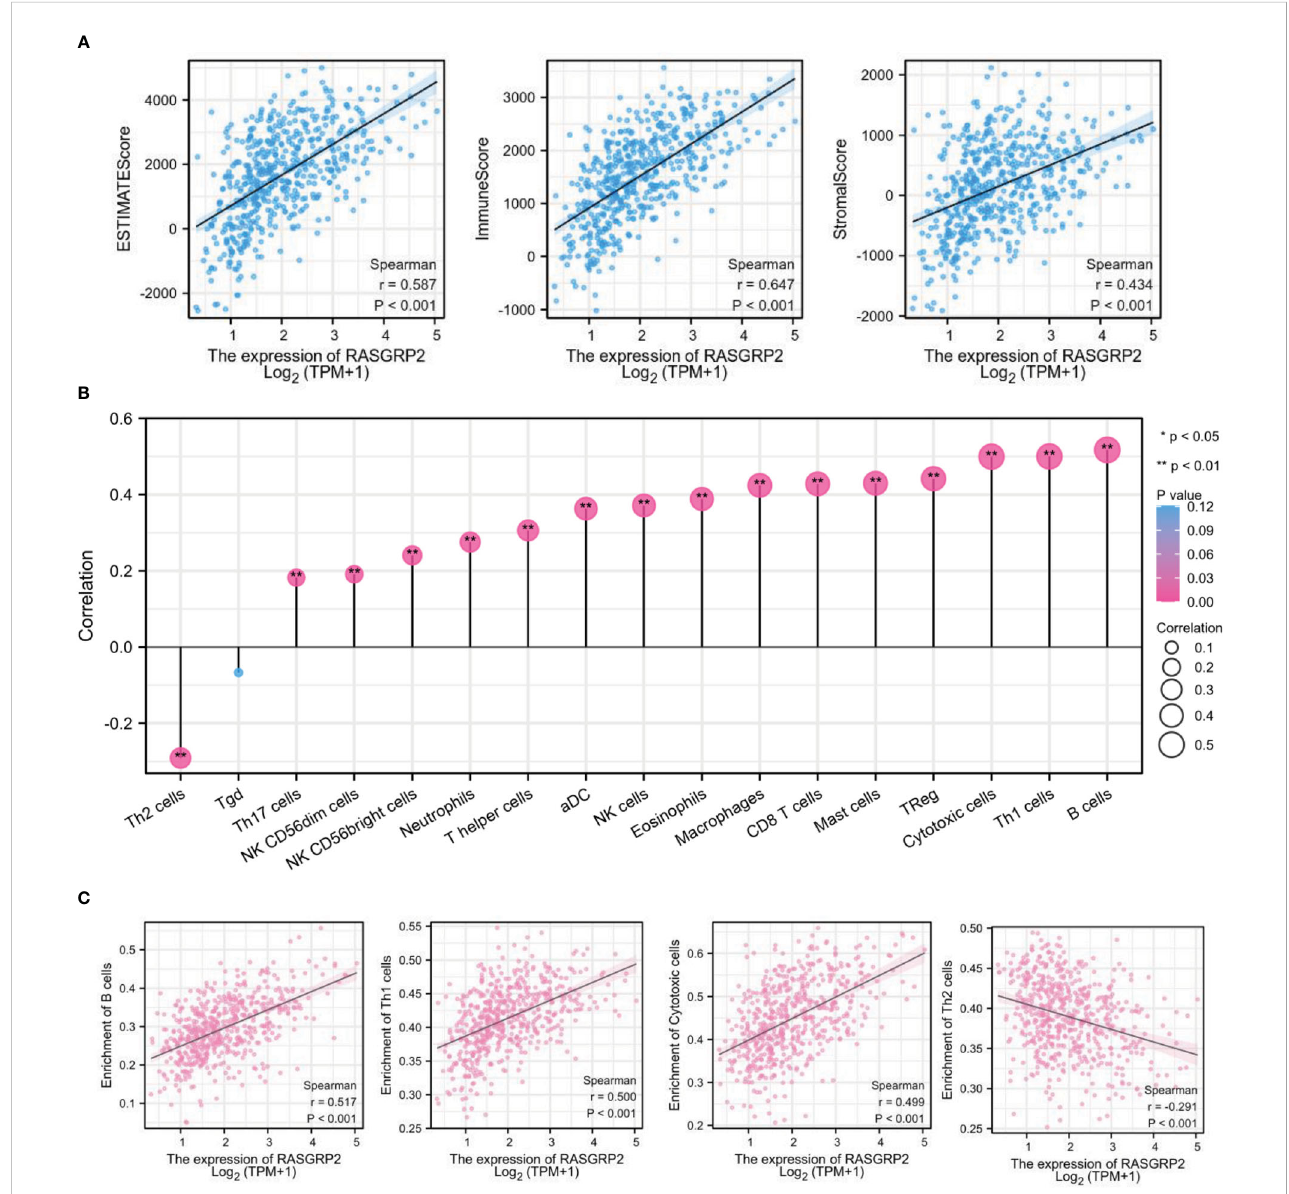
FIGURE 8 RASGRP2 was positively associated with immune in fi ltration in LUAD. (A) Based on the ESTIMATE, RASGRP2 expression was positively correlated with the ESTIMATE Score, Immune Score and Stromal Score. (B) The lollipop plot suggested the correlation of 26 different immune cell subtypes with RASGRP2 expression level. (C) The expression of RASGRP2 was positively correlated with B cells, Th1 cells and cytotoxic cells in fi ltration, but negatively correlated with Th2 cells. **P < 0.01, *P <